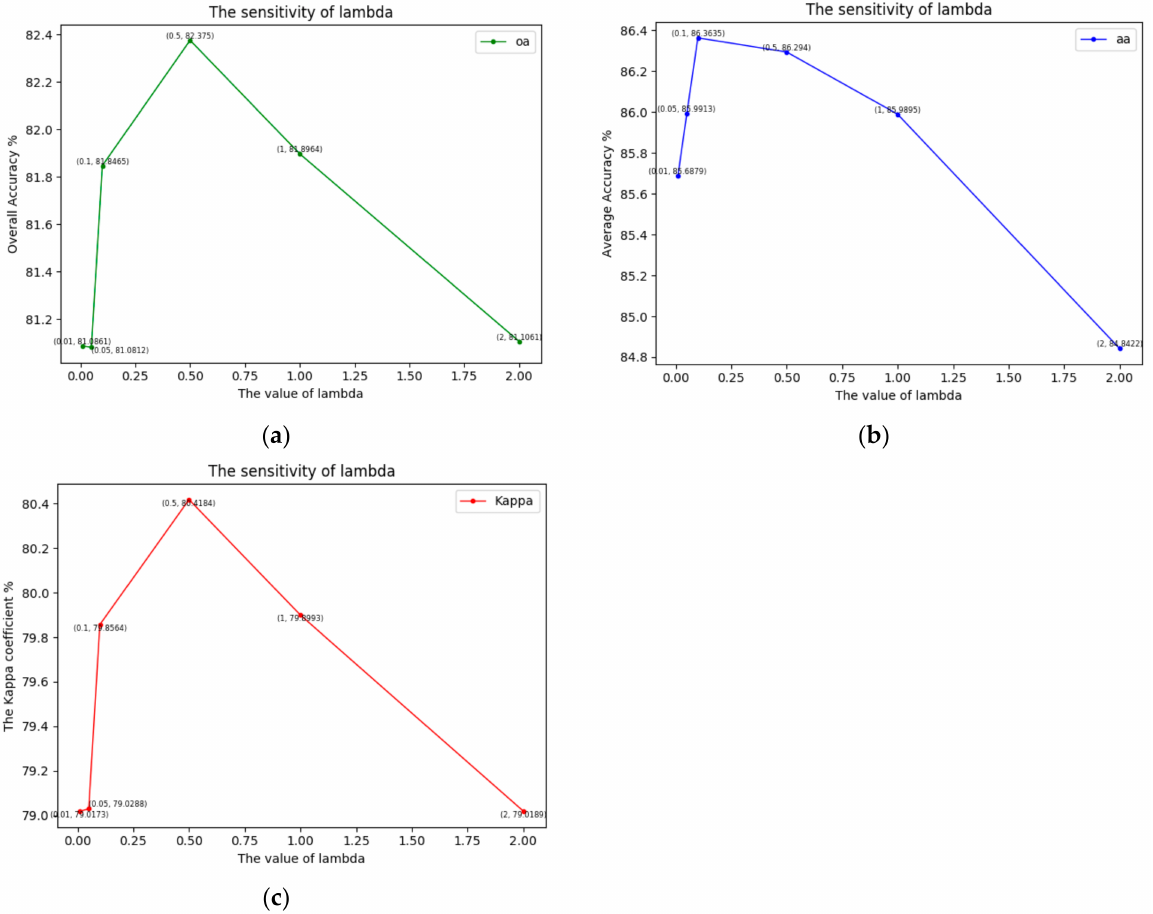
Figure 16. Illustration of the sensitivity of λ . It reflects the classification accuracy of OA, AA and k with different values of λ . ( a ) OA; ( b ) AA; ( c ) k